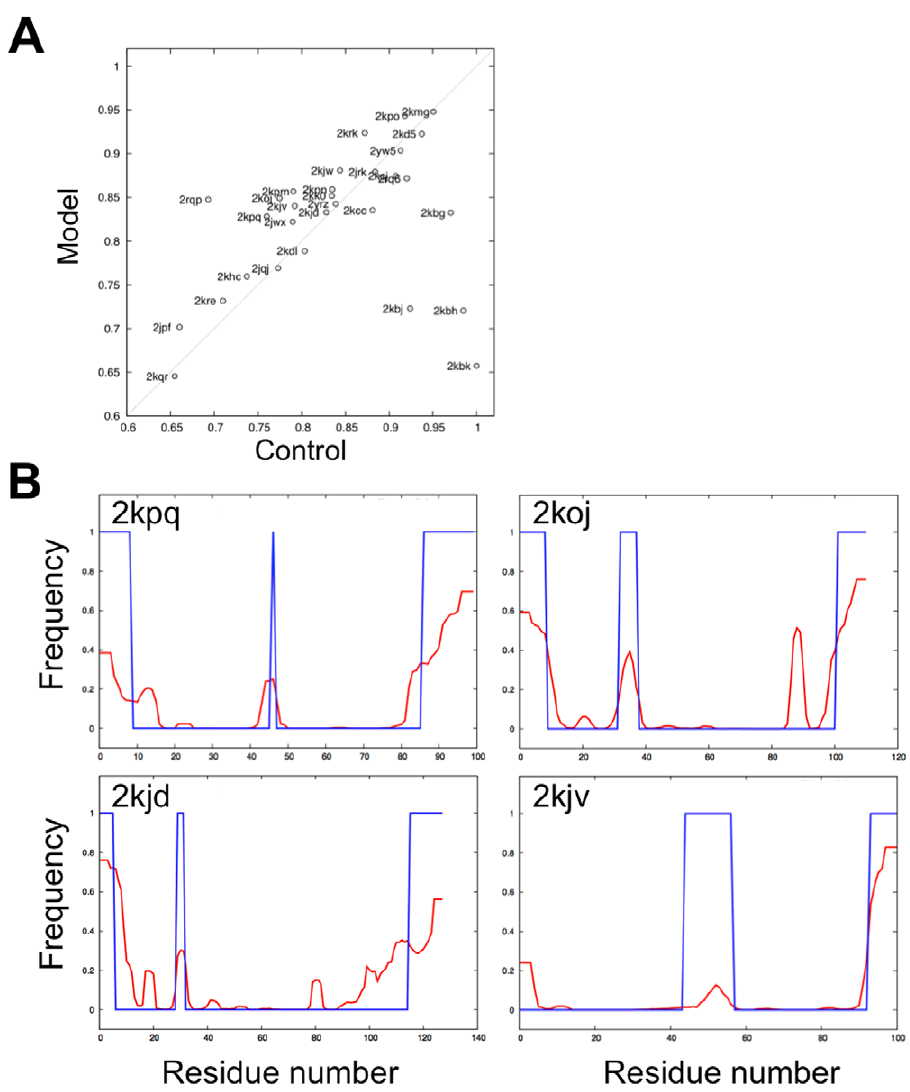
Figure 3. Results of disordered internal loop predictions. ( A ) Comparisons of prediction accuracy using the free energy function with optimized parameters ( b =1.5 and L 0 =0.3) with that of a null model. The y-axis shows disorder prediction accuracy over the benchmark set using Eq. (2). The x-axis shows the prediction of the null model, which assumes all residues are ordered. ( B ) Examples of successful prediction of disordered internal loops. Blue line: the actual disordered regions assessed from the residue deviations in the NMR structure. Red line: frequency of disorder assignment by optimization of Eq. (1) over decoy population.